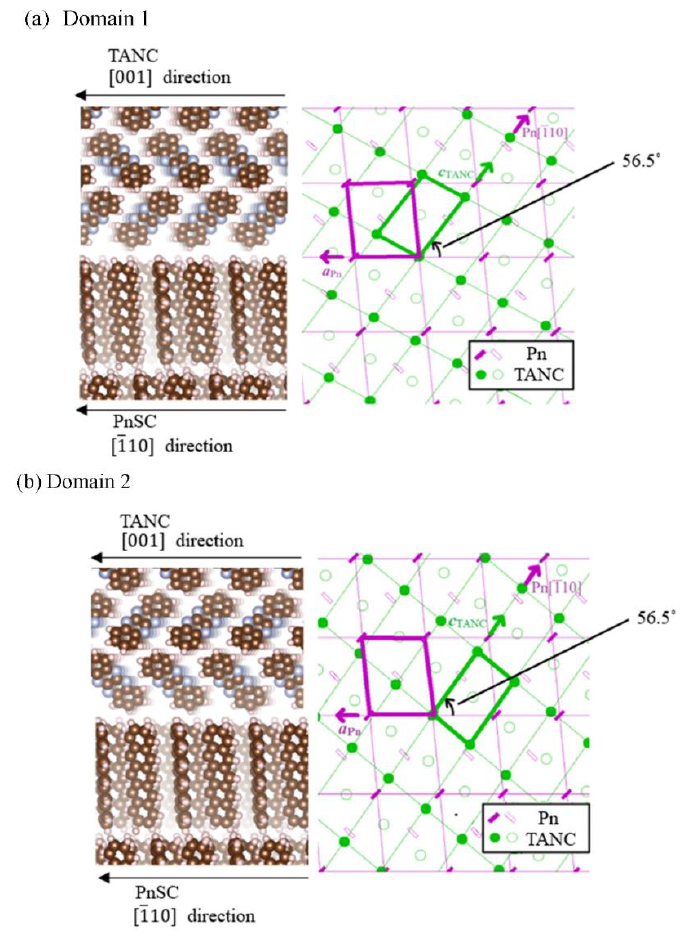
Figure 3. A schematic drawing of the expected molecular orientations for ( a ) Domain 1 and ( b ) Domain 2.